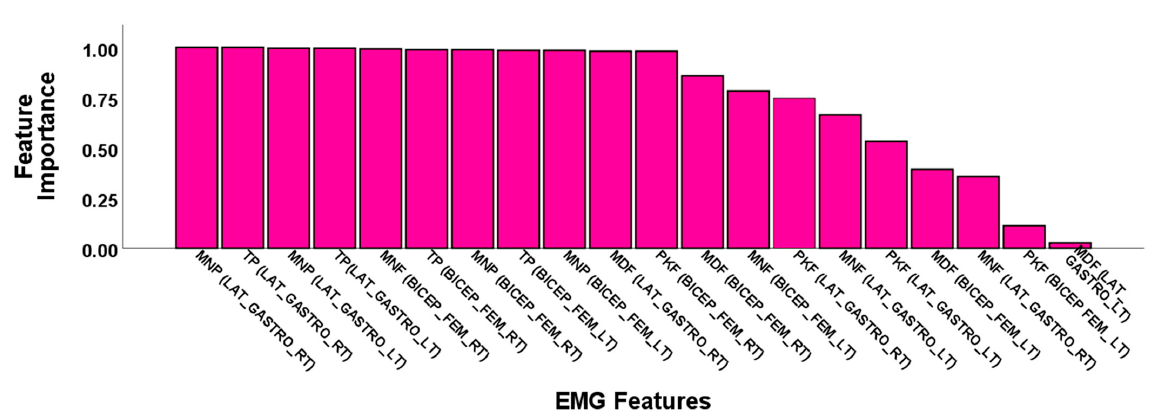
Figure 4. Feature importance of the EMG power spectrum features in the feature selection process of machine learning analysis to distinguish stroke and control groups.